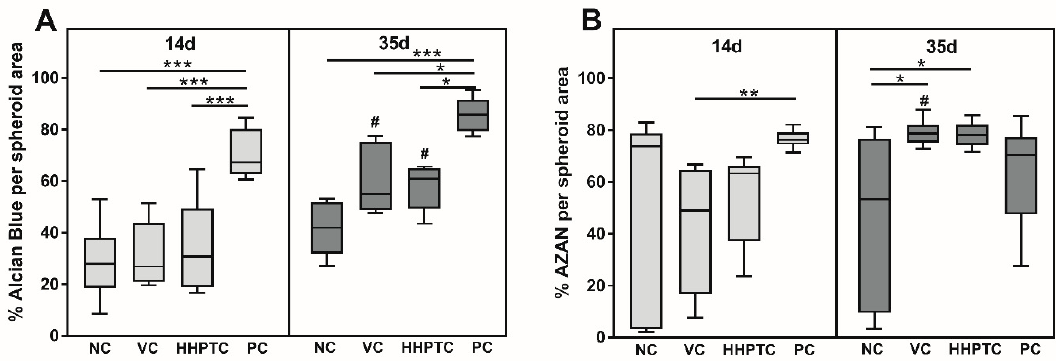
Figure 7. For quantitative analysis of Alcian blue ( A ) and AZAN staining ( B ), the relative blue stained area was determined with ImageJ. For normalization, the measured blue stained area was divided by the total area of the spheroid slice. Data are presented as boxplots with minimum, 25th percentile, median, 75th percentile and maximum. Statistical analysis was performed using Repeated Measures Two-way ANOVA with Bonferroni’s multiple comparison as post hoc test. Significance: * p < 0.05, ** p < 0.01, *** p < 0.001 between treatments and # p < 0.05 comparison between day 14 and 35.